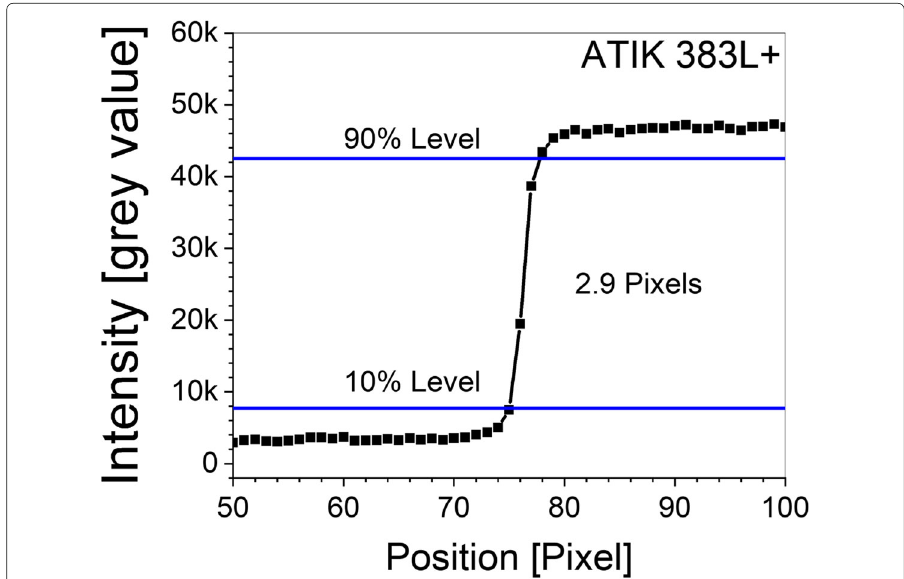
Fig. 12 Exemplary demonstration of the 10% to 90% method for determining the spatial resolution of the camera system. The curve shows the intensity profile around the edge of the